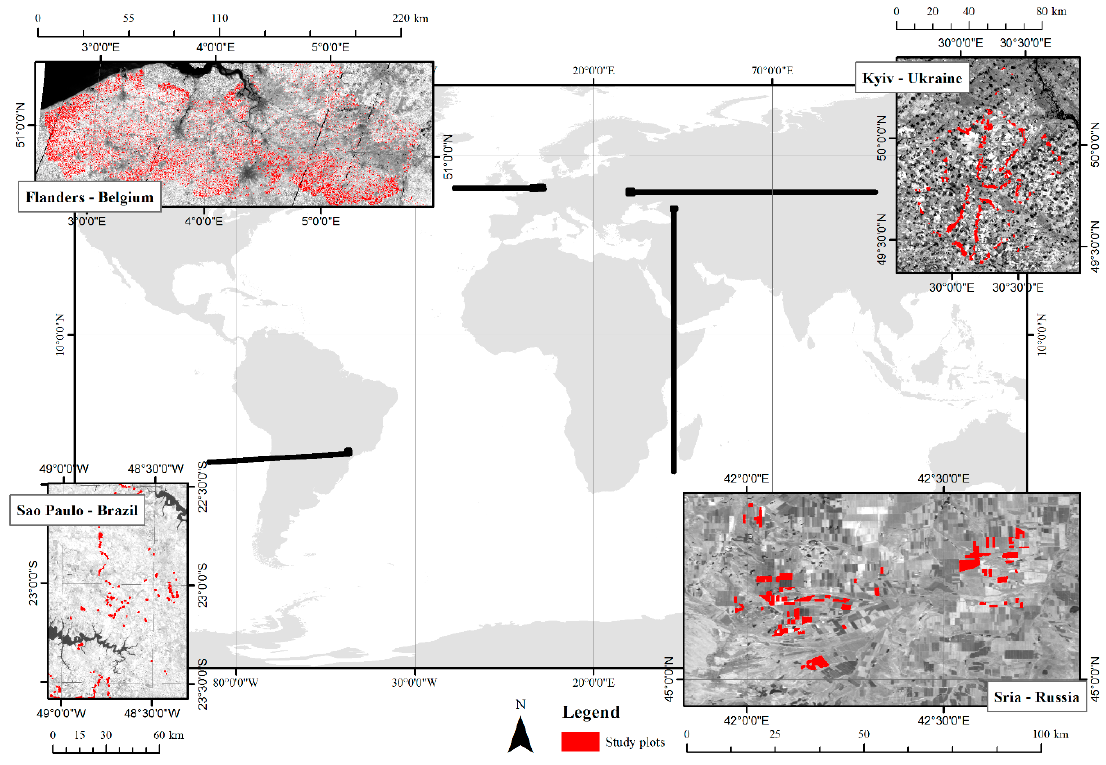
Figure 1. Study sites overlaid with field boundaries. The background images were extracted from the 100-m Proba-V red band.